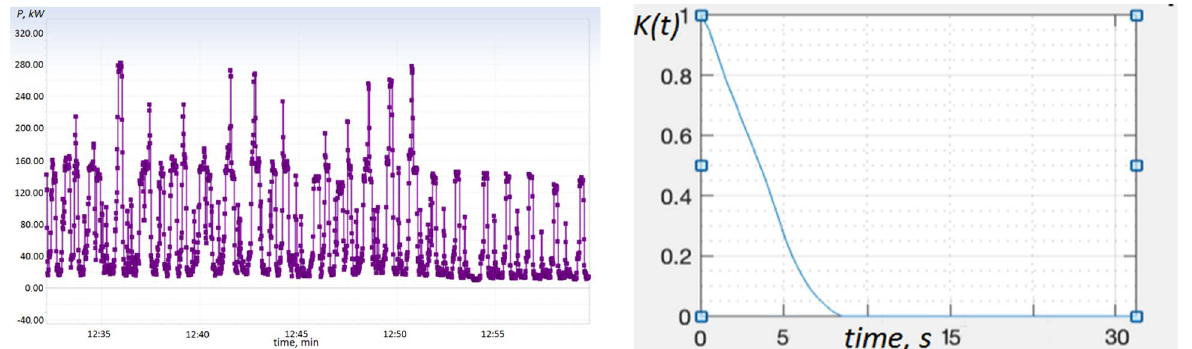
Figure 6. Fragment of the curve of active power consumption crushers with a VFD and his NCF.